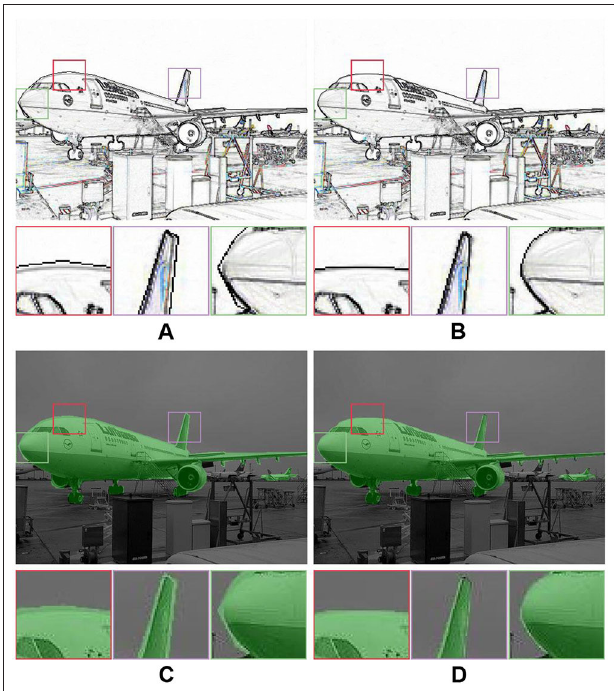
FIGURE 15 | Label correction for natural images. (A) Original edge; (B) Corrected edge; (C) Original mask; (D) Corrected